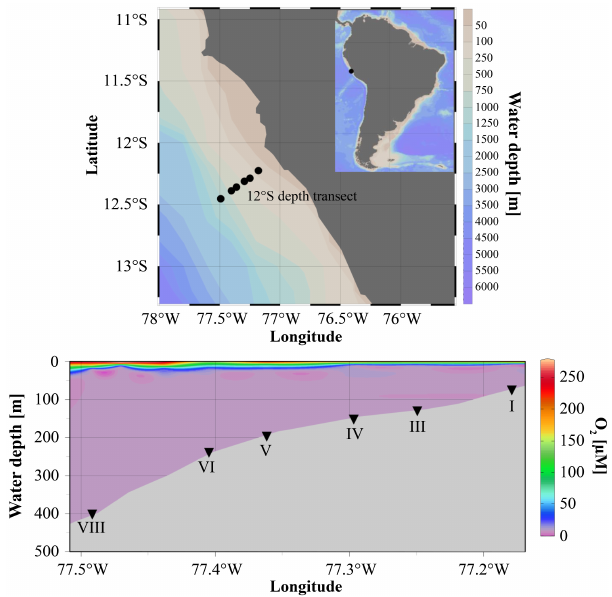
Figure 1. Study area, sampling stations, and O 2 concentration in µM along the 12 ◦ S